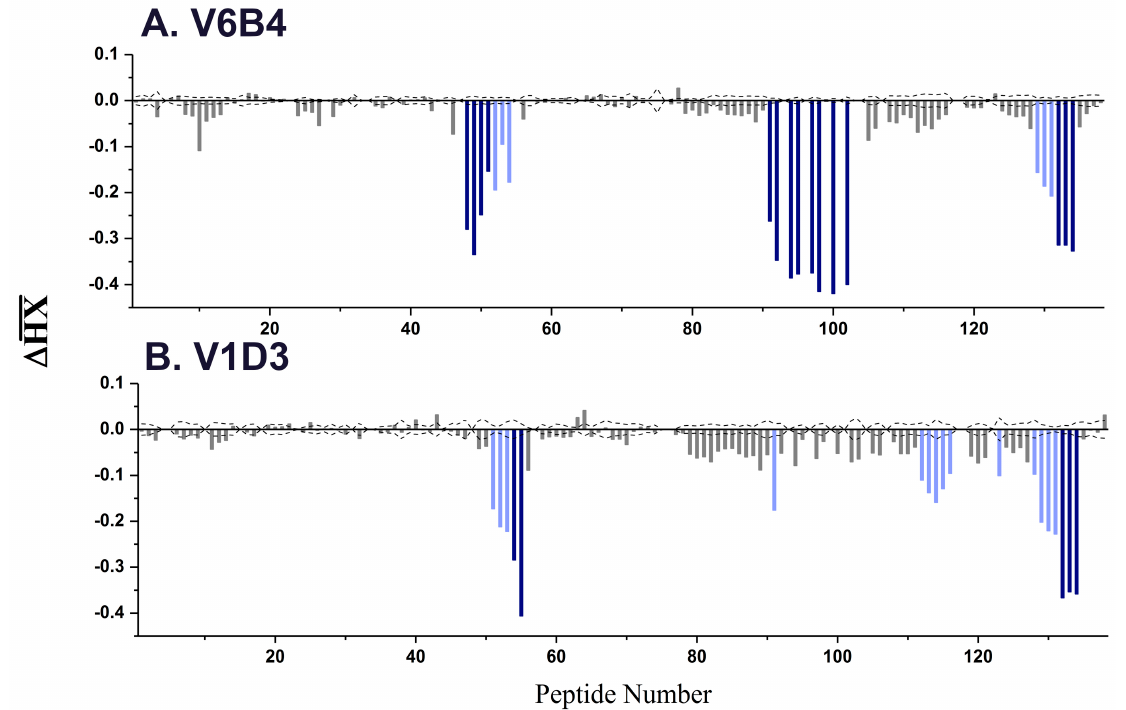
Figure 4. HX-MS analysis of RiVax bound to two V H Hs in subcluster 3.1. The ∆ HX values for each RiVax peptide are shown for V H Hs ( A ) V6B4 and ( B ) V1D3. The ∆ HX values are clustered using k-means clustering into three categories: strong (deep blue), intermediate (light blue) or no significant protection (gray). The dotted lines represent “3 σ ” confidence intervals for statistically significant changes in hydrogen exchange.